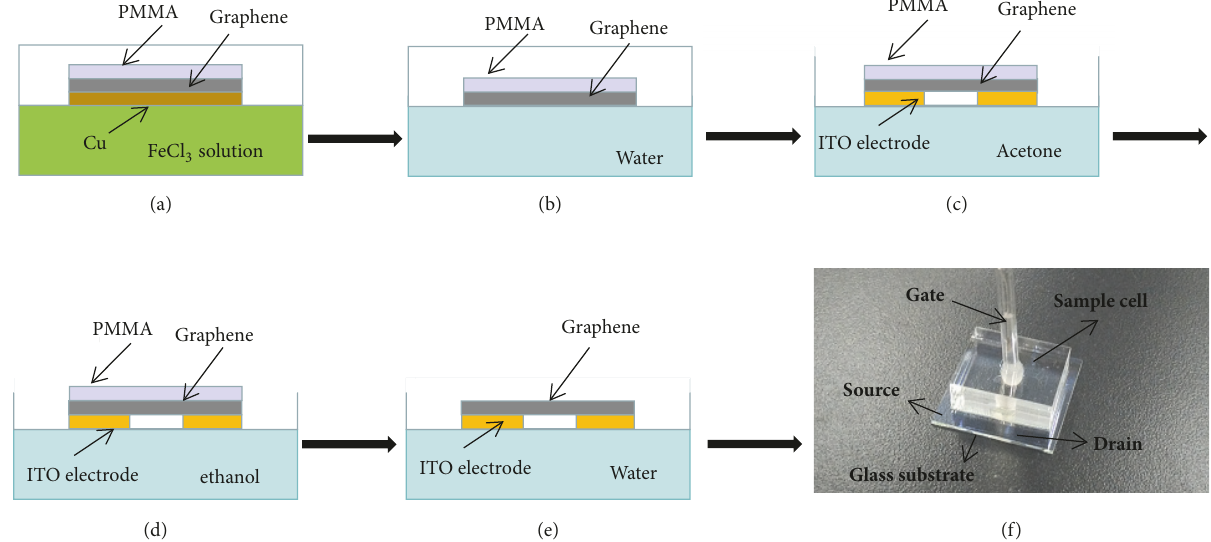
Figure 1: Schematic of the graphene transfer and G-FET fabrication. (a)–(e) Graphene film transferred onto the glass substrate with two ITO electrodes. (f) Photo of the fabricated G-FET.